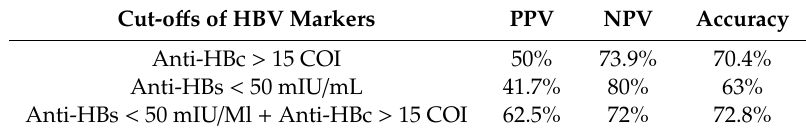
Table 4. Diagnostic performance of serological HBV markers in predicting cryptic serum